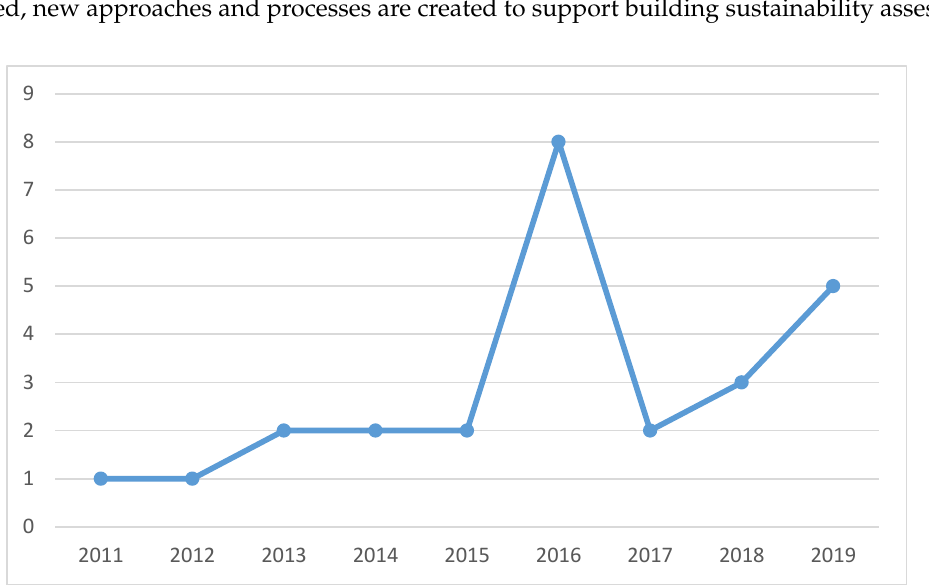
Figure 8. Total articles published per year (LEED, BREEAM and SBTool).